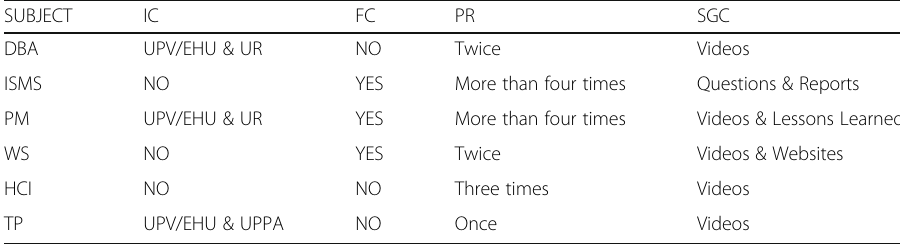
Table 1 Teaching techniques used in the